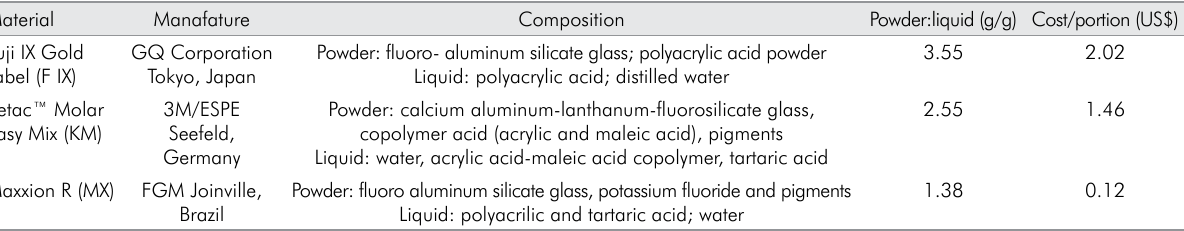
Table 1. Glass Ionomer Cement: material, manufacturer and composition, proportion powder:liquid and cost per portion (US$). Material Manafature Composition Powder:liquid (g/g) Cost/portion